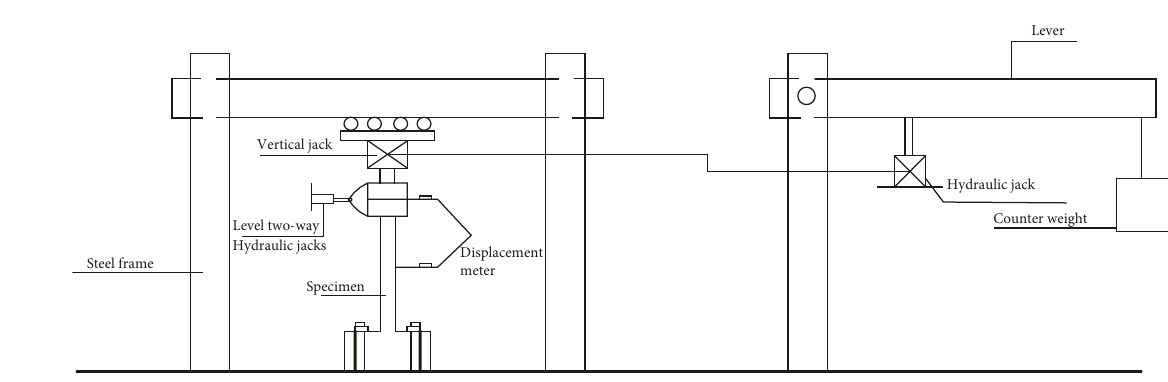
Figure 5: Loading device.